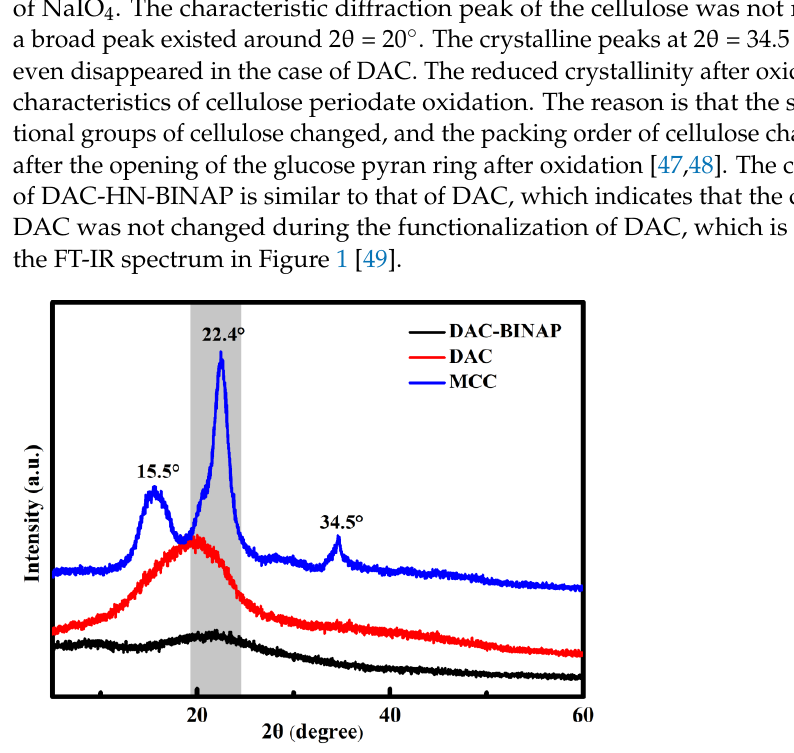
Figure 2. XRD spectra of MCC, DAC and